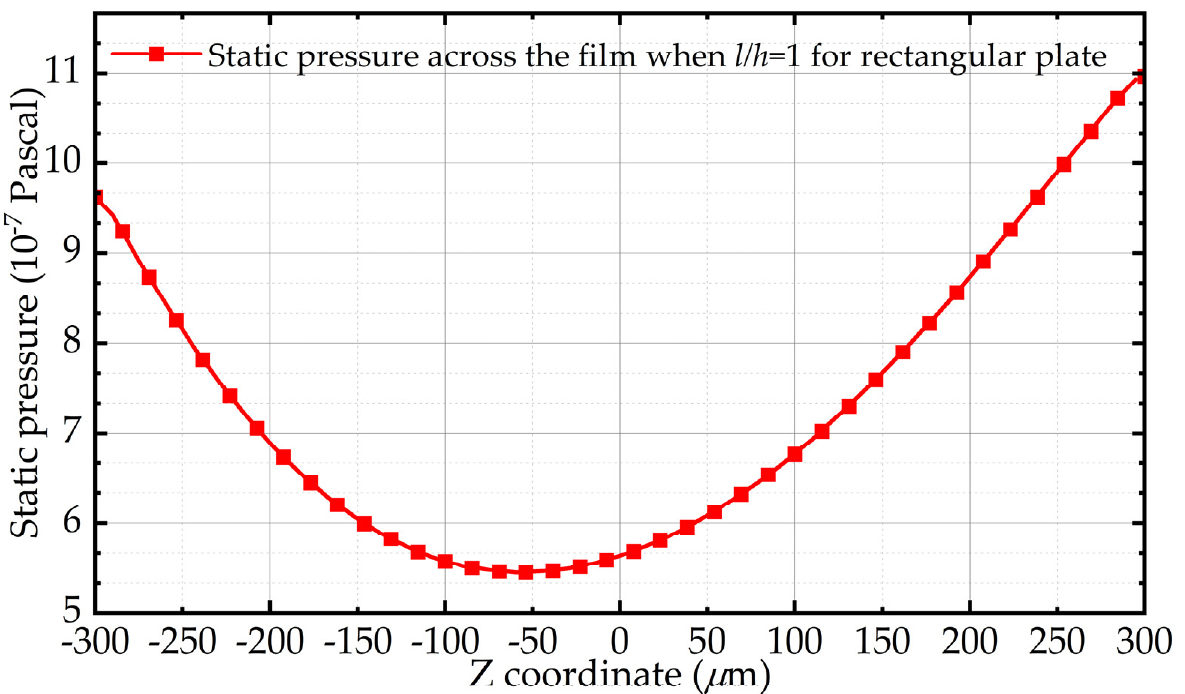
Figure 1. Distribution of static pressure along the thickness of air film in the simulation when the length of the plate and the film thickness are both 600 μ m.